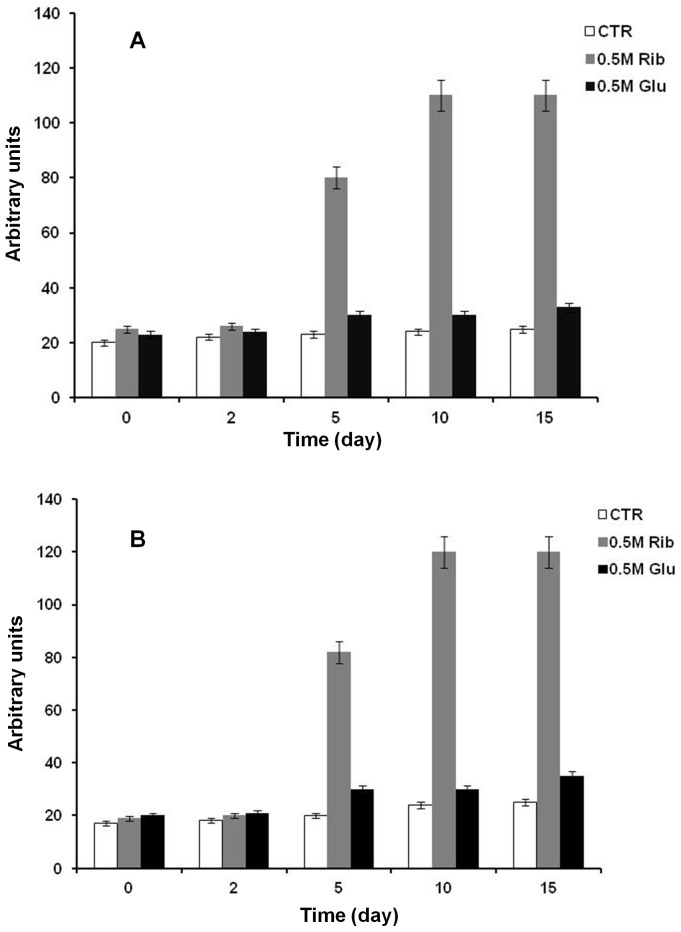
Glycation of the W7FW17F apomyoglobin.Protein glycation monitored by fluorescence spectroscopy. W7FW14F apomyoglobin was incubated in the absence (white bar) and in the presence of 0.5 M D-ribose (grey bar) and 0.5 M D-glucose (black bar) and changes in maximal fluorescence intensity were monitored at different time intervals. Protein concentration was 40 µM, other experimental details are described in the Materials and Methods section. (A) Maximal fluorescence intensity recorded at 410 nm upon excitation at 320 nm. (B) Maximal fluorescence intensity recorded at 425 nm upon excitation at 370 nm. The average value (±SD) of a quadruplicate experiment is plotted.